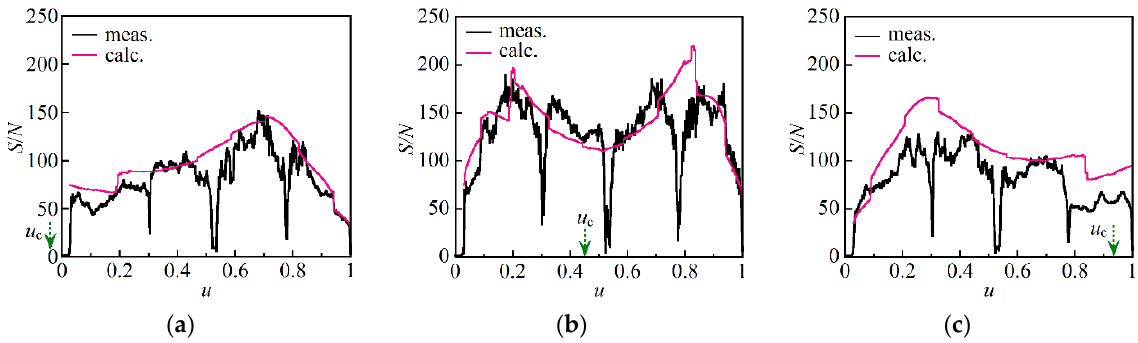
Figure 7. Distributions of S/N along the 1.35 m long optical fiber, which were measured and calculated at ( a ) u c = − 0.042, ( b ) u c = 0.45 and ( c ) u c = 0.93, where the DFB LD was driven with current source B whose power spectral density is shown in Figure 5b. The scale of the horizontal axis is normalized in such a way that the output end of the fiber under test was unity. The rapid changes of S/N observed around u = 0.31, 0.53 and 0.78 were caused by fusion splicing and mating of the pieces of the optical fiber.